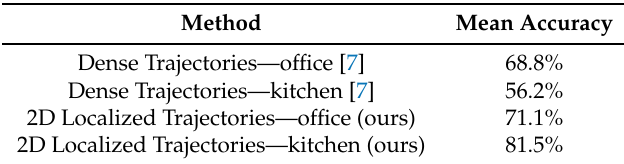
Table 4. Mean accuracy of recognition (%) on Watch-n-Patch in both kitchen and office settings for Dense Trajectories and 2D Localized Trajectories approaches.